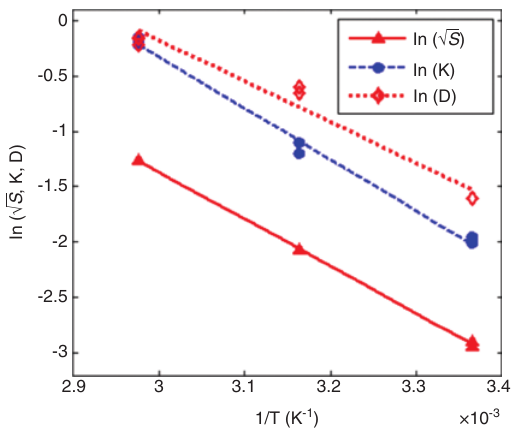
Figure 5: Temperature dependence of fitted model parameters (Class H cement, w/c =